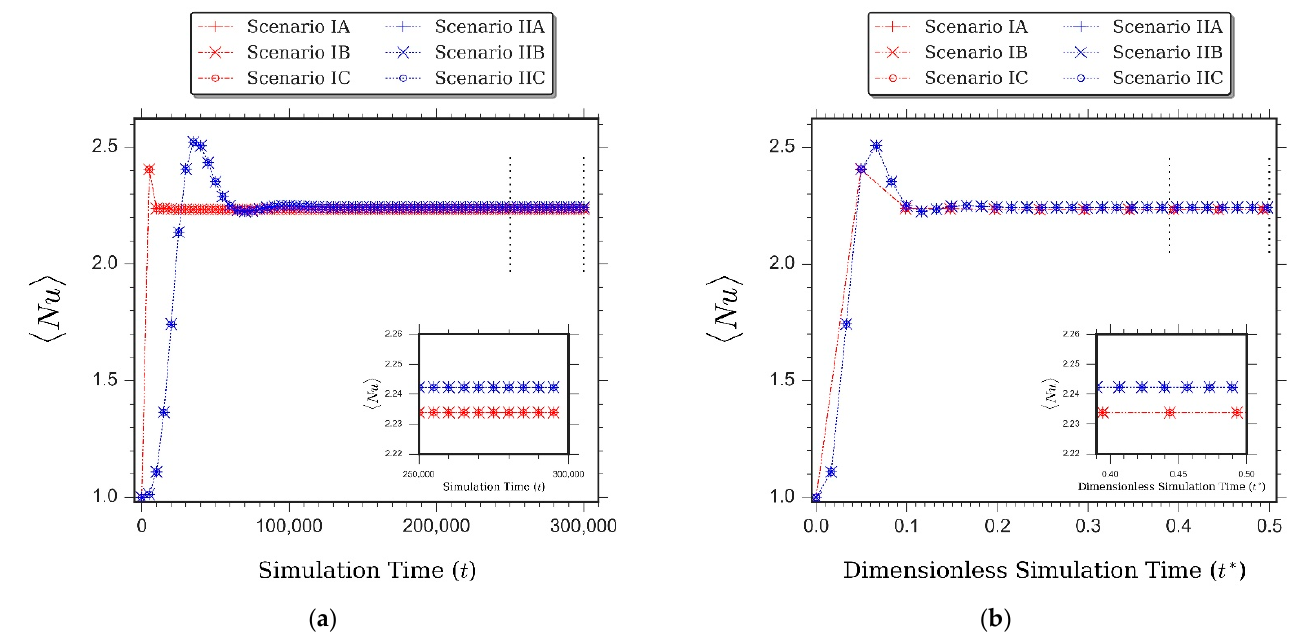
Figure 3. Profiles of average Nusselt number ⟨ Nu ⟩ from different LBM scenarios during the unsteady period up to the accomplishment of the steady-state condition of the natural convection a in differentially-heated cavity for Ra = 10 4 , Pr = 0.71 , τ υ = 0.6 , and Ma = 0.1 , showing computational behaviour with ( a ) dimensional simulation time t as the horizontal axis, and ( b ) dimensionless simulation time t * as the horizontal axis. Figure insets demonstrate the magnification of the computational characteristics in the steady-state region of the simulation.